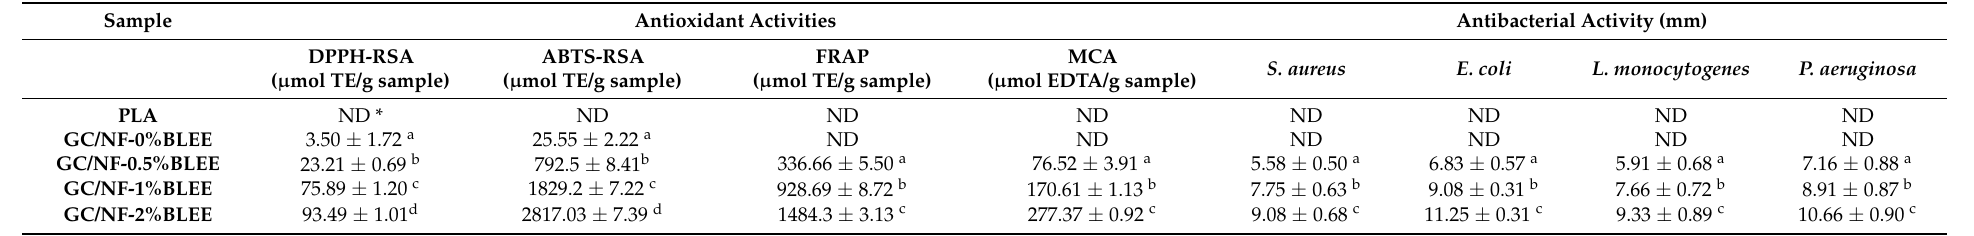
Table 3. Antioxidant and antibacterial activities of PLA film and PLA films coated with GC/NF loaded with and without BLEE at different